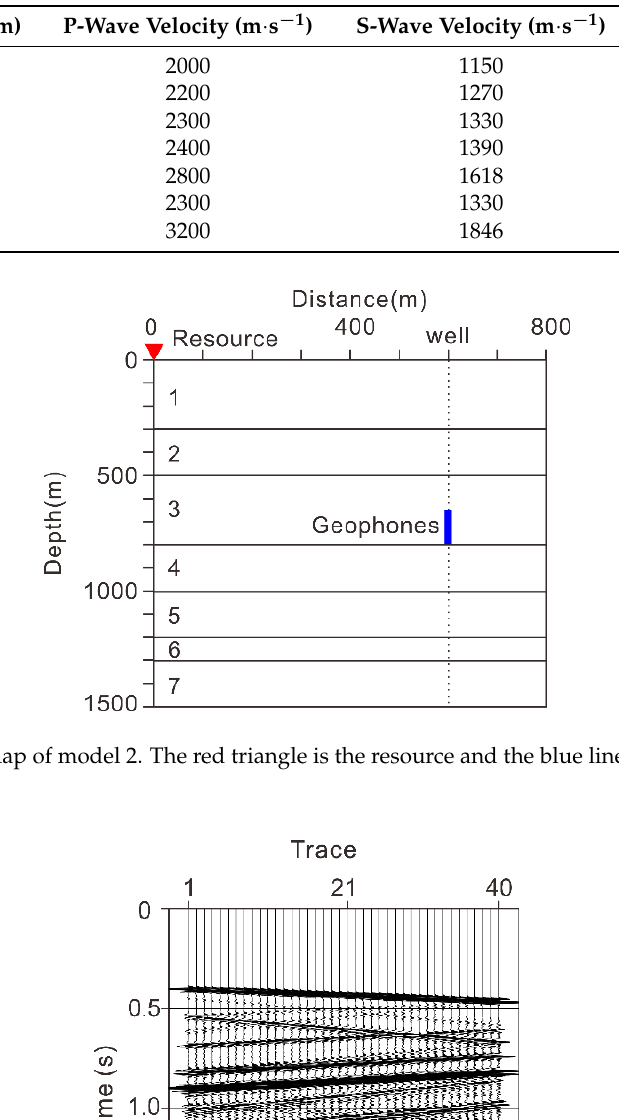
Table 2. Parameters of model 2.